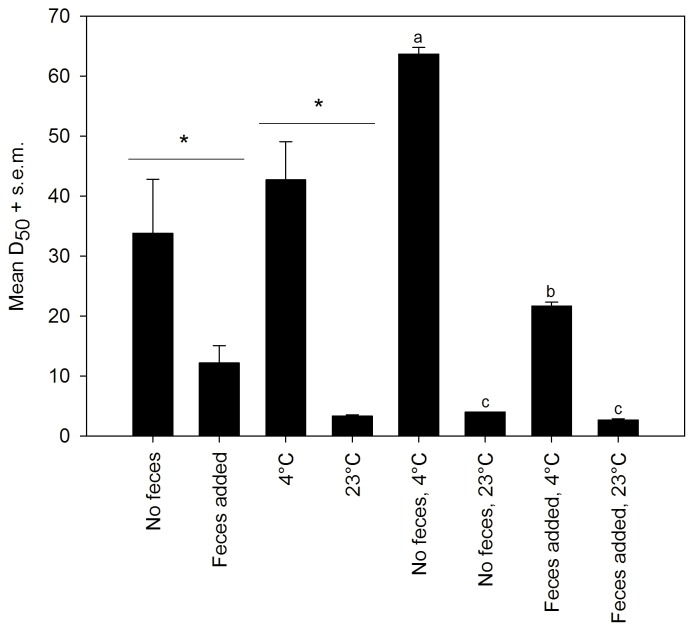
Ceftiofur metabolites remain biologically available in topsoil under different conditions.Effect of temperature and addition of cattle feces (1∶25) on ceftiofur metabolites (CFM) as measured by recovery of growth for E. coli K-12 (D50). Main effects and interactions were significant (P<0.0001; two-factor ANOVA). Letters designate group differences based on Tukey-Kramer multiple comparison test (P<0.001). Bars = s.e.m.